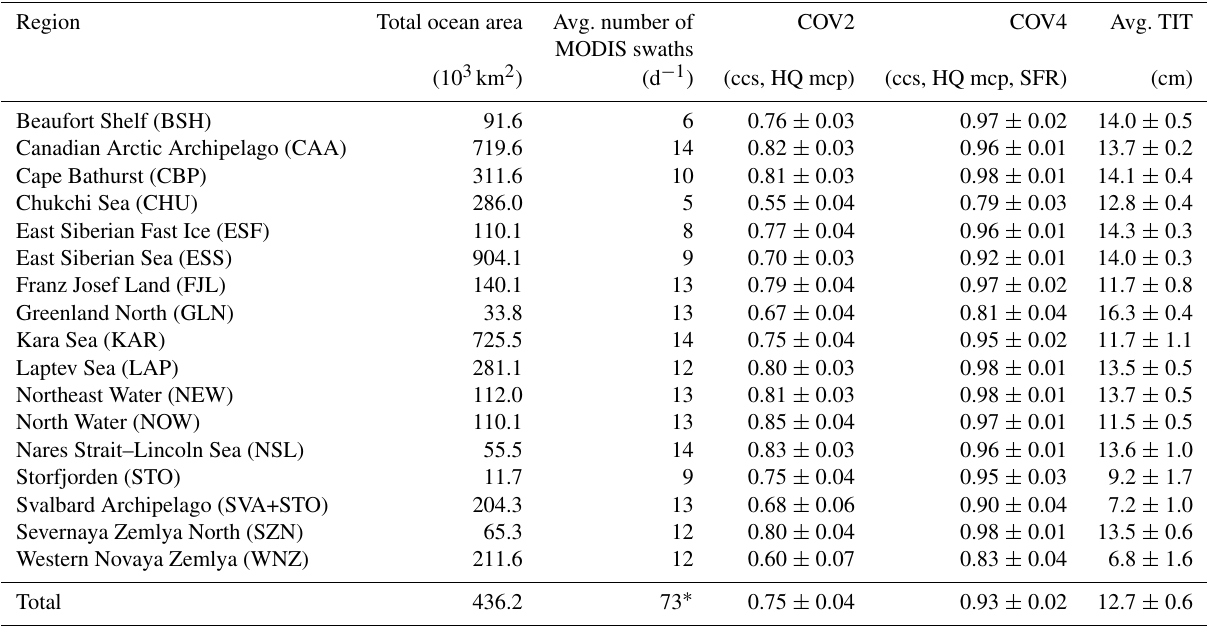
Table 1. Areal extents (i.e., total ocean area) of all applied polynya masks in km 2 . Furthermore, the interannual average amount of MODIS swaths that could be used for calculating daily composites in a given region is indicated, together with the interannual average daily MODIS coverage (decimal cover fraction ranging from 0 to 1 with their respective standard deviations) before (COV2) and after (COV4) application of the spatial feature reconstruction (SFR) for each polynya region from 2002–2003 to 2014–2015 (November to March). The abbreviation “ccs” denotes confident clear-sky coverage, while “HQ mcp” are high-quality mixed-cover pixels where either MODIS or ERA-Interim medium cloud cover feature cloud signals in the daily composites. In addition, the average thin-ice thickness (TIT, incm) inside each polynya region (for all TIT ≤ 0.2m) is given together with its standard deviation. An overview on all applied predefined polynya masks is given in Fig.